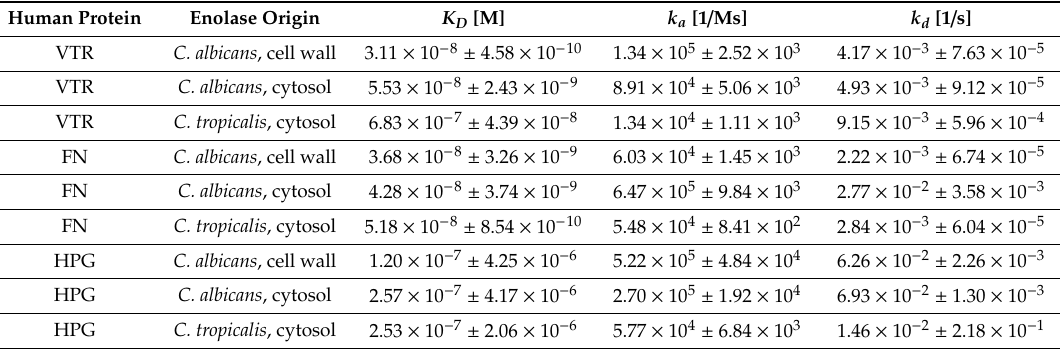
Table 1. Kinetic and thermodynamic parameters for the interactions of C. albicans and C. tropicalis enolases with VTR, FN or HPG, determined by SPR measurements. The SPR-determined k a , k d and K D values were obtained for enolase as a ligand and for human proteins as an analyte. All parameters are presented with the standard error.